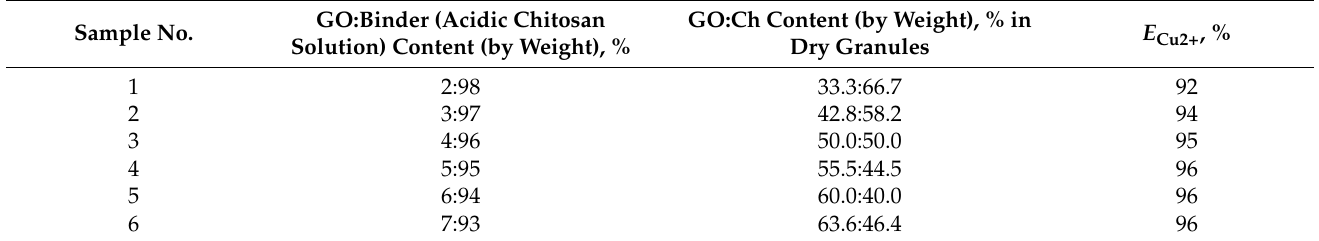
Figure 4. FTIR spectroscopy of: ( a ) thermally reduced graphene oxide, ( b ) graphene oxide. Analysis of the effectiveness of the purification of stock solution from copper cations by the obtained GO-Ch sorbents of various compositions is presented in Table 1. Table 1. Relationship between the effectiveness of copper cations recovery and the composition of the initial mixture and dry granules of the experimental samples of the GO-Ch composite. Sample No.